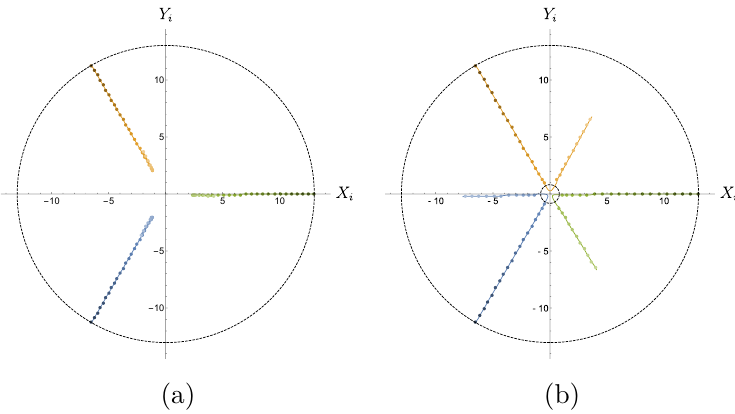
Figure 39 . Trajectories ( X i ( t ) , Y i ( t )) of n = 3 type II non-Abelian vortices with parallel internal orientations, scattering with initial velocity u = 0 . 5 (a) and u = 0 . 7 (b). The vortices start on the circle of diameter a = 8 L (outer dashed circle) moving first towards the origin and then scattering at away from it (points go from darker to lighter shades). The inner dashed circle in (b) has diameter L/ 2 , and within it there is no way to distinguish individual